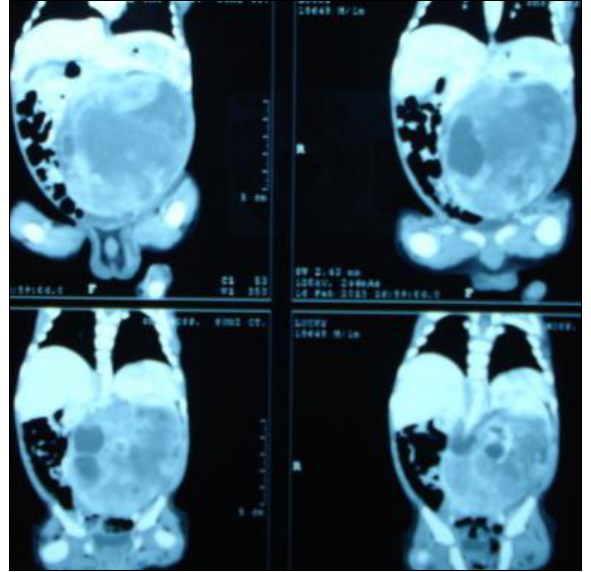
Figure 1: Left renal mass, heterogeneous in nature showing cystic